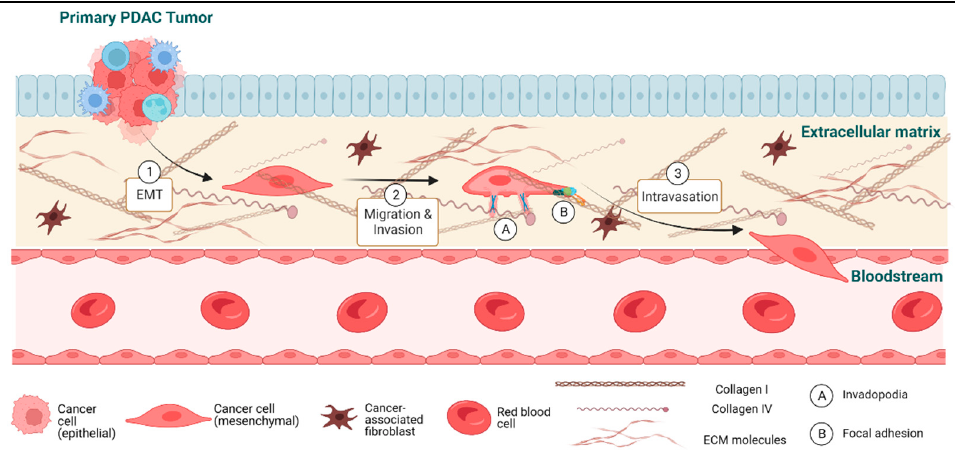
Figure 1. Early metastatic cascade in PDAC. (1) Epithelial-to-mesenchymal transition (EMT) is one of the hallmarks of metastasizing tumor cells. EMT is associated with several molecular and mor- phological changes, including loss of cell–cell adhesions and apico-basal polarity and reduced pro- liferation, as well as the upregulation and downregulation of several mesenchymal (e.g., N-cad- herin) and epithelial (e.g., E-cadherin) markers, respectively. (2) Metastasizing tumor cells migrate and invade the surrounding extracellular matrix (ECM) either alone or in cell clusters. PDAC is associated with a strong desmoplastic reaction that can both promote and inhibit cancer cell migra- tion and invasion. PDAC cells rely on structures such as invadopodia to invade and degrade the surrounding ECM, while using structures such as focal adhesions to adhere and move through the ECM. Focal adhesions rely on integrin-mediated interactions with the proteins that comprise the ECM, including collagens and fi bronectins. (3) The fi nal step in the early metastatic cascade involves the extravasation of the tumor cells into the bloodstream or lymphatics, through which they can travel in circulation and potentially form distant metastases elsewhere in the body. Figure created on BioRender.com.